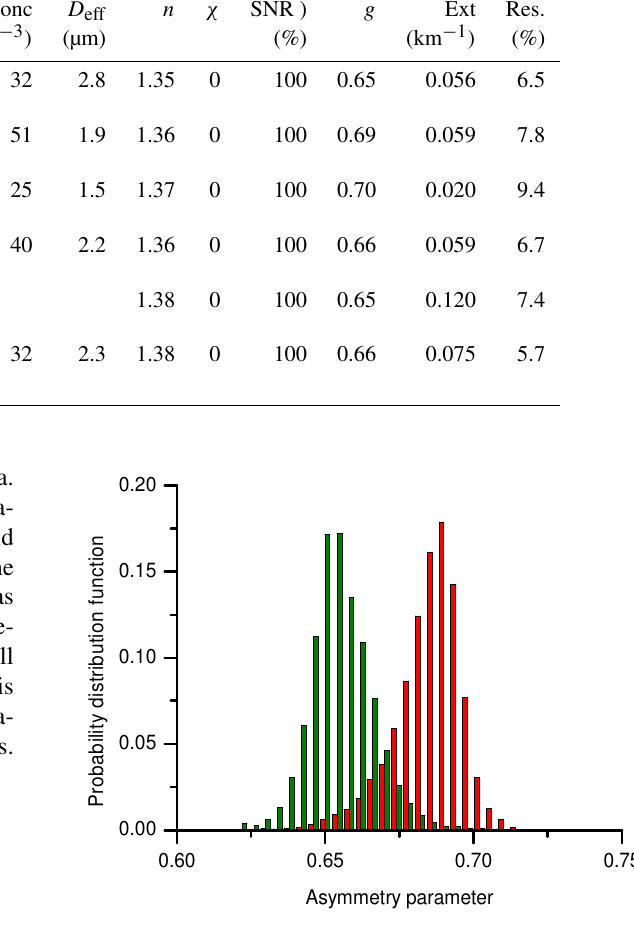
Figure 5. Probability distribution functions of the asymmetry pa- rameter. Bocca Nuova (BNa, red) and Northeast (NECb, green) Etna craters plums, respectively. (See notations in Fig.